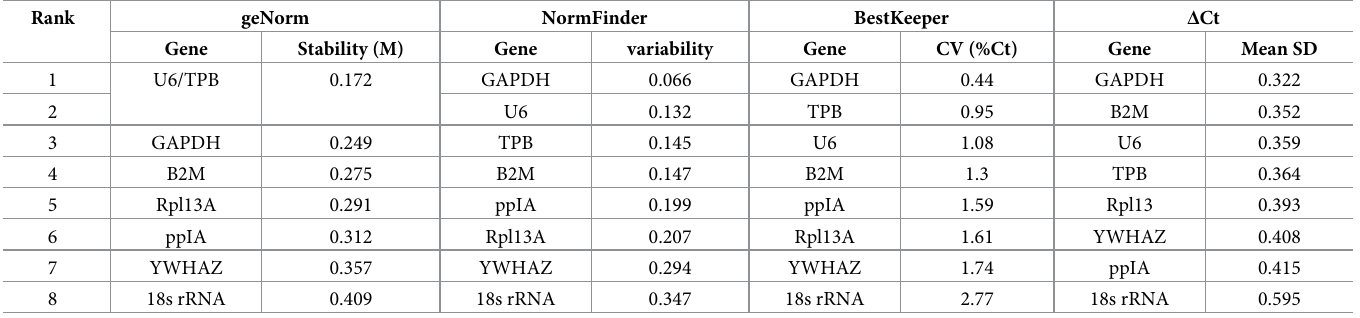
Table 2. Ranking order of the candidate reference genes by four programs: geNorm, NormFinder, BestKeeper and Δ Ct. Rank geNorm NormFinder